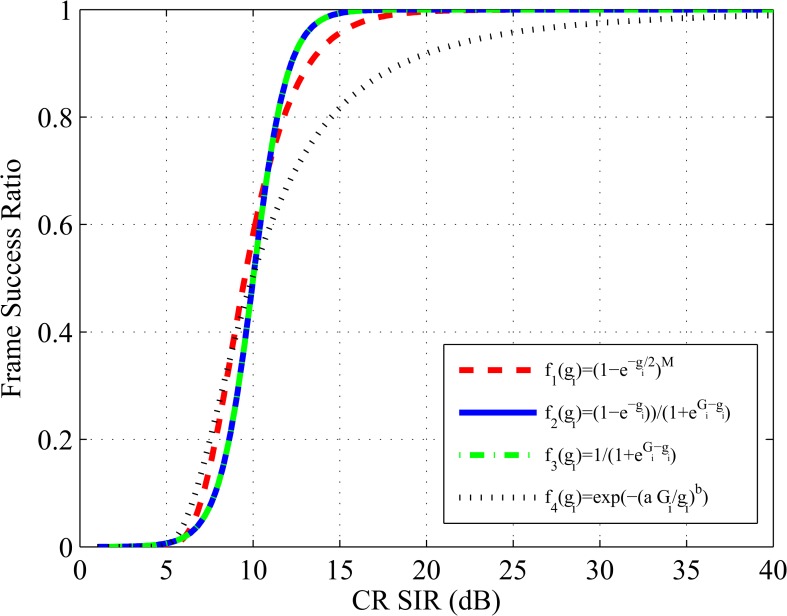
Efficiency function comparison Γi = 10, a = 0.8, b = 3, M = 80.